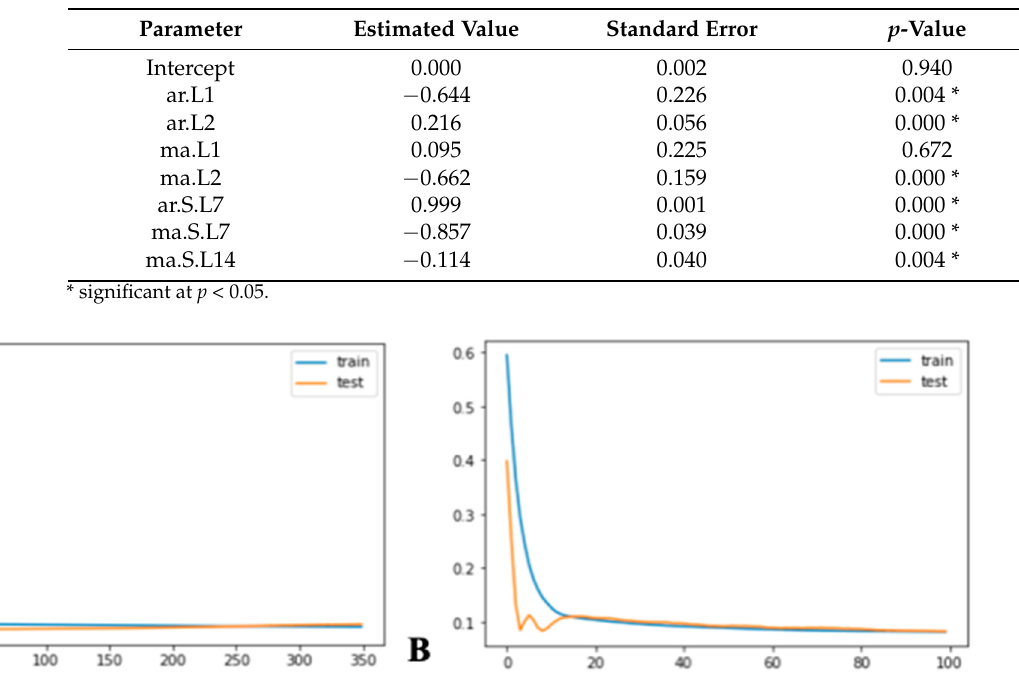
Table A1. Parameter Estimates for SARIMA (2,1,2)(1,0,[2])7 with a One Day Forecast Time Horizon.